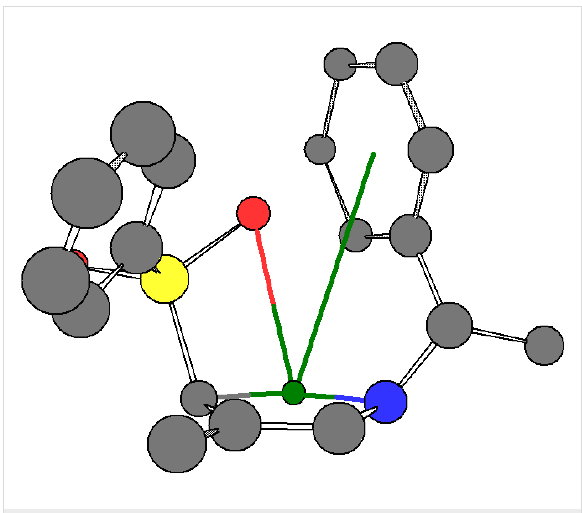
Figure 1: Calculated minimum energy conformation of lithiated amino- substituted sulfone 1a showing π-interaction between Li + ion and remote phenyl nucleus of the α-methylbenzylamine (1-phenylethyl- amine) moiety; gray = C, green = Li, blue = N, yellow = S, red = O, hydrogen atoms are omitted for